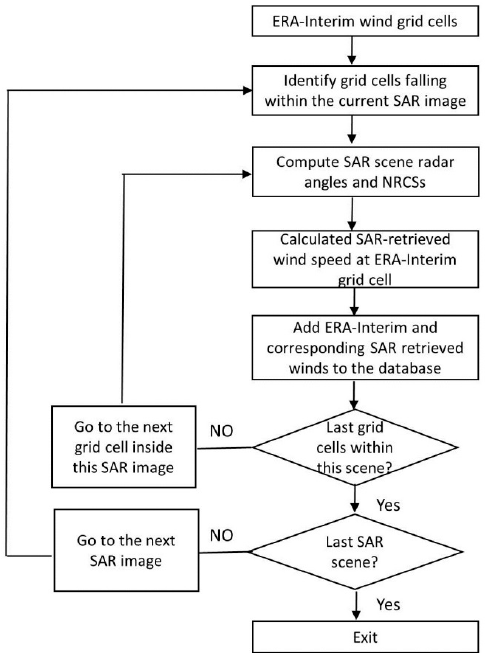
Figure 2. Flowchart for building a database for the developing wind speed retrieval method.